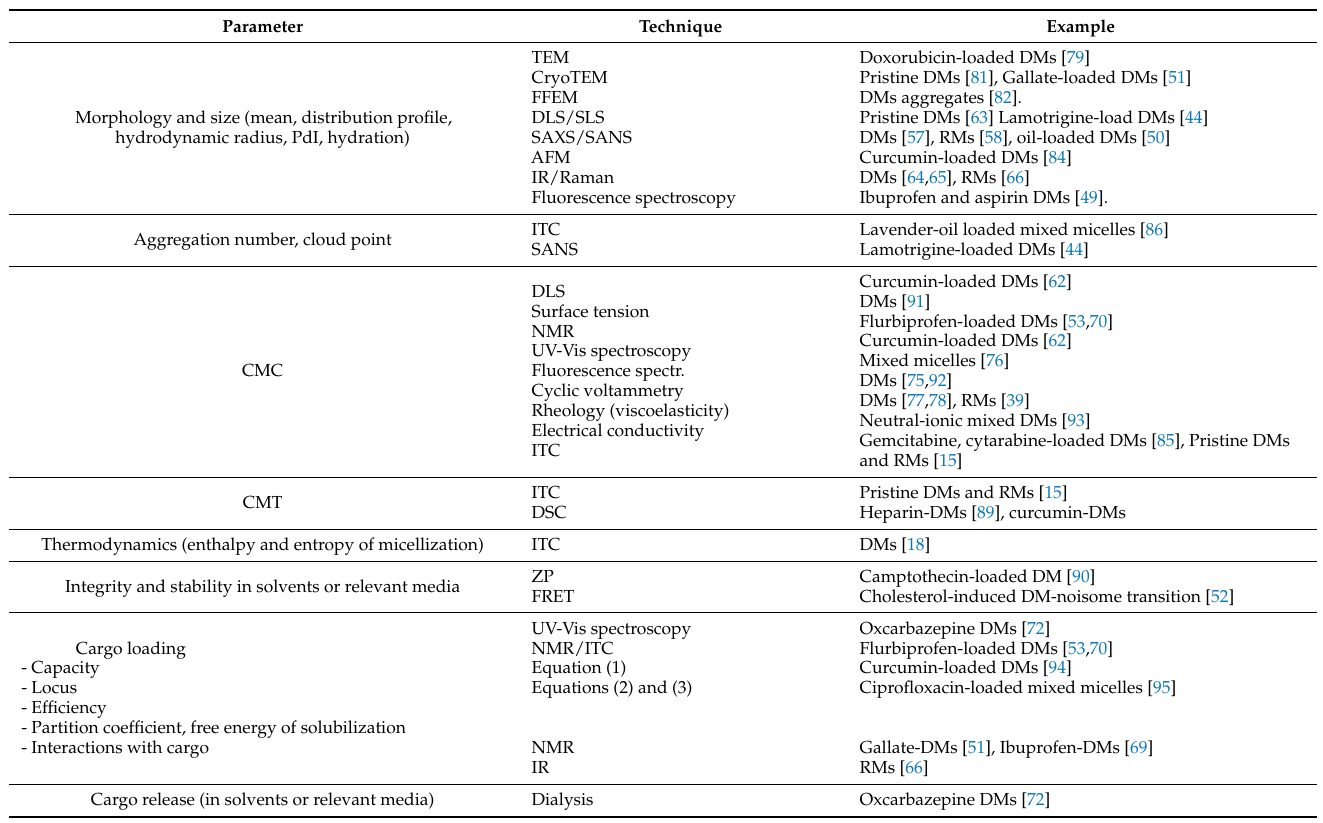
Table 4. Relevant parameters for Pluronic micelles and characterization techniques to measure such parameters. Parameter